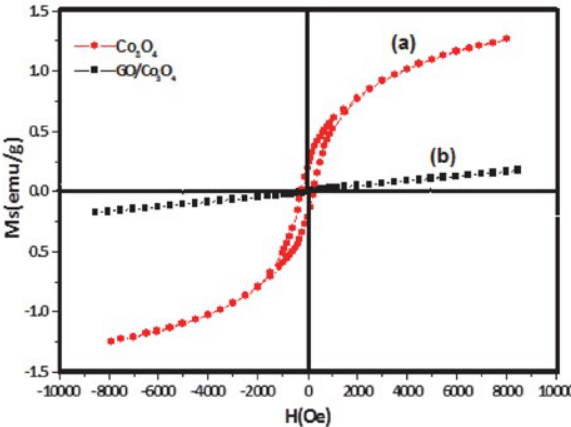
Figure 7. Magnetic hysteresis loops of (a) Co (b) GO/Co